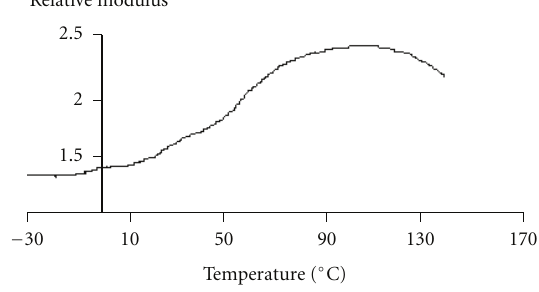
Figure 7: Relative storage modulus